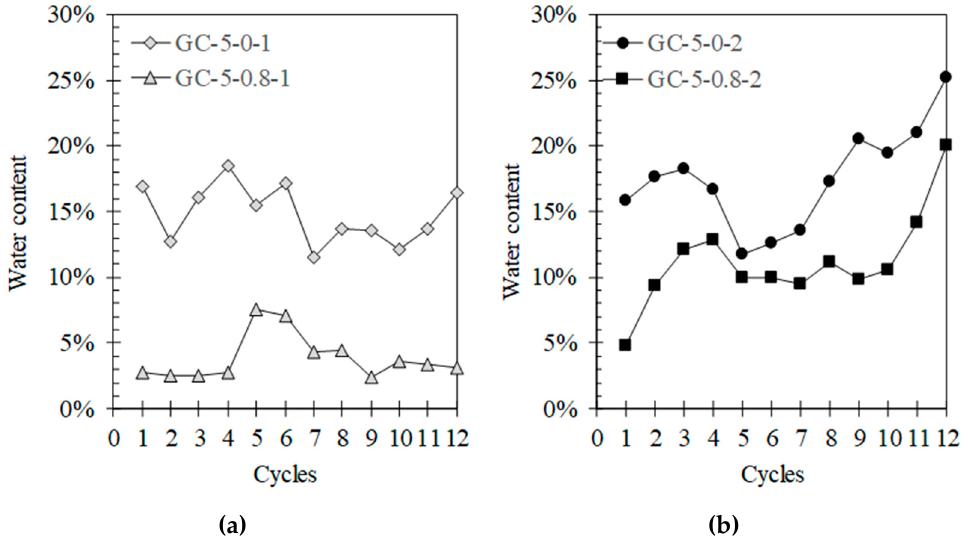
Figure 5. Water content alteration throughout the wetting–drying cycles. ( a ) Volume and moisture change specimens, and ( b ) soil–cement loss specimens.